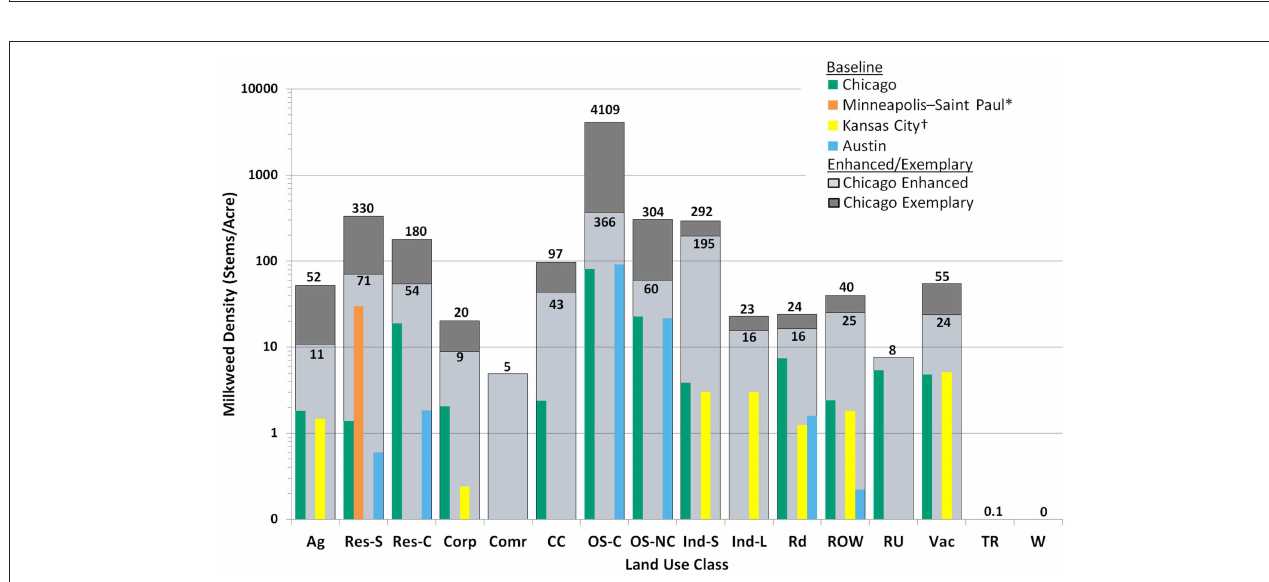
FIGURE 9 | Average milkweed stem densities by consolidated land use categories for existing conditions in Chicago (green), Minneapolis-St. Paul (orange), Kansas City (yellow), Austin (blue). *Baseline densities for Minneapolis-St. Paul were only collected for Res-S, so Chicago baseline values were used for all other land use classes. † Baseline densities for Kansas City were not collected for OS-C and OS-NC, so Chicago baseline values were used for these land use classes. Densities from Chicago are also shown for enhanced sites (light-gray bars), and exemplary conditions (dark-gray bars). All densities shown are on a plantable space basis. Density values are displayed in log space to fit all